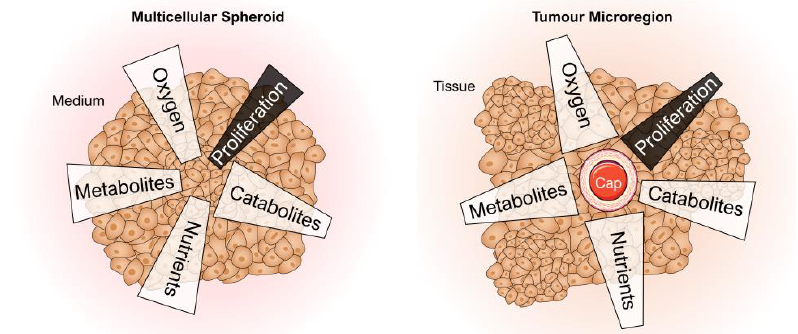
Figure 5. Schematic of the analogy between a multicellular spheroid ( left ) and a tumour ( right ) to illustrate the pathophysiological inside-out situation described by Kunz-Schughart [62]. Cap: capillary. Parts of the figure were drawn by using pictures from Servier Medical Art, licensed under a Creative